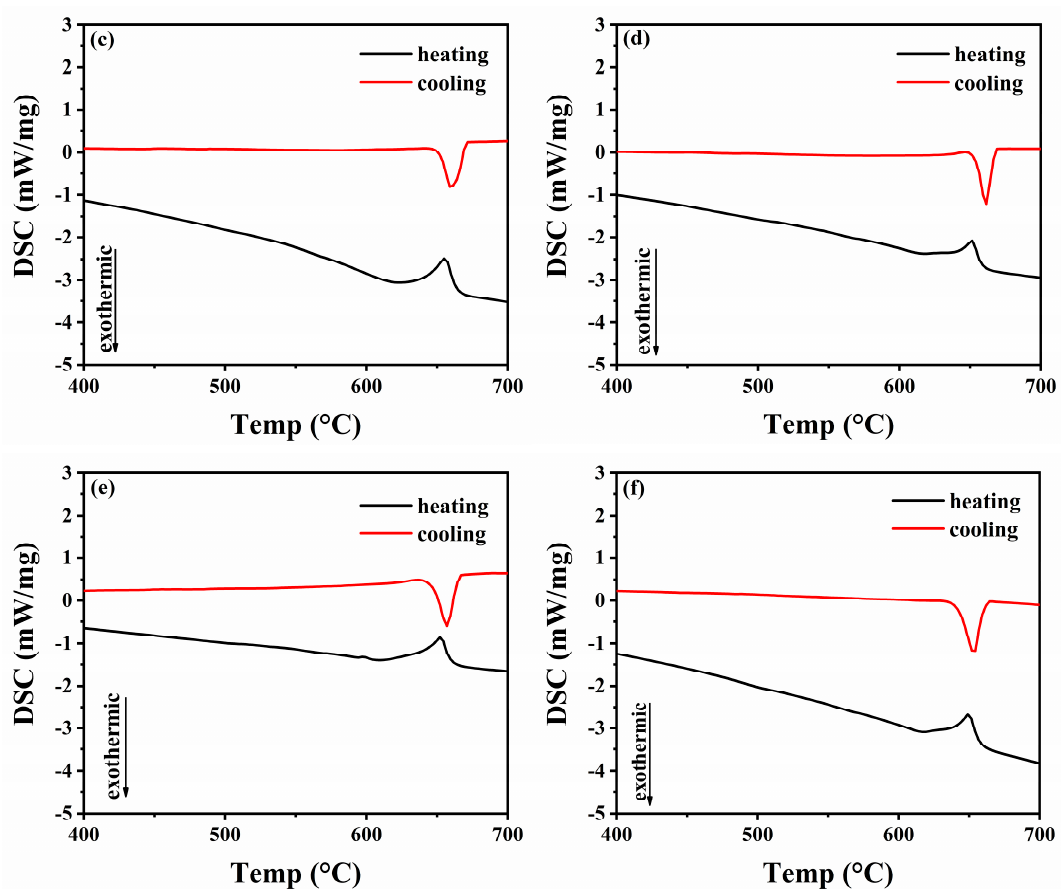
Figure 8. Differential scanning calorimetry (DSC) curve of as-cast alloys: ( a ) Al-3Mg-0.5Mn; ( b ) Al-3Mg-0.5Mn-0.2Er; ( c ) Al-3Mg-0.5Mn-0.2Zr; ( d ) Al-3Mg-0.5Mn-0.2Cu; ( e ) Al-3Mg-0.5Mn-0.2Si; ( f ) Al- 3Mg-0.5Mn-0.2Zn. Table 3. DSC curve analysis results of as-cast alloys / °C.